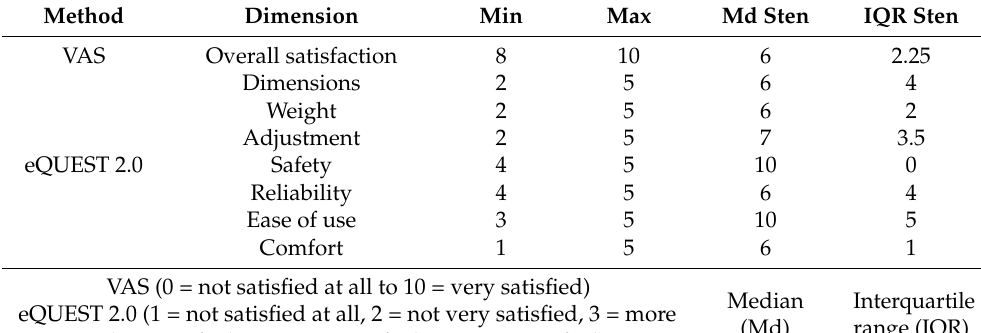
Table 2. Satisfaction assessment during the session ( n = 11, missing case = 1).